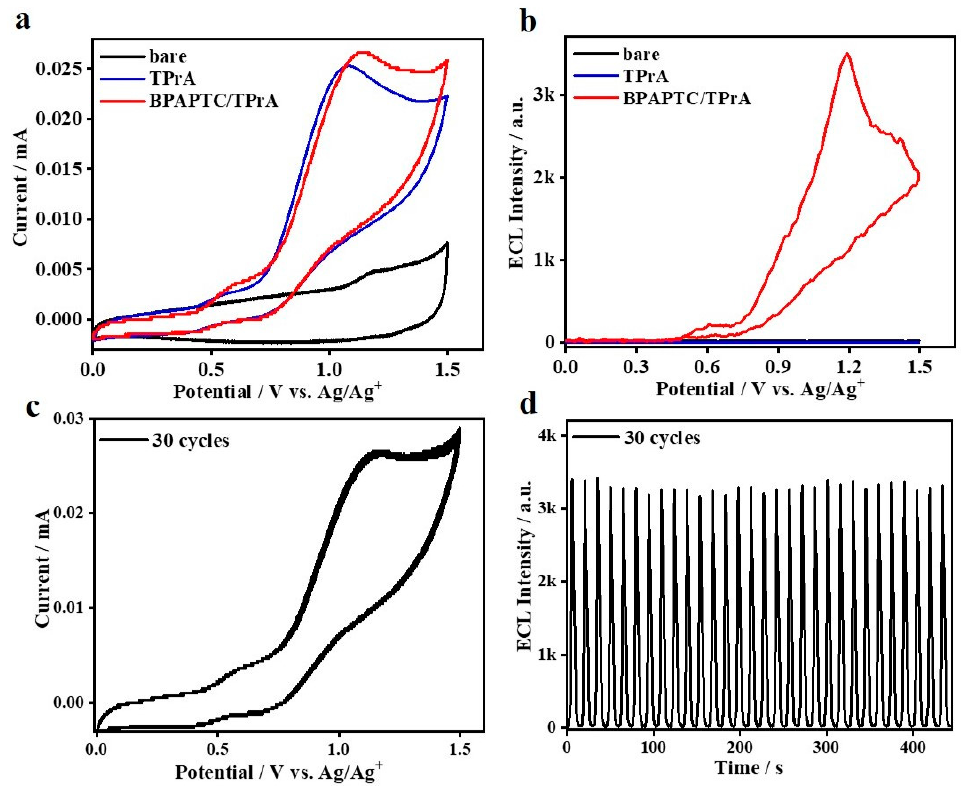
Figure 5. ( a ) CVs and ( b ) ECL curves of bare DCM, bare DCM containing 25 mM TPrA, 0.1 mM BPAPTC containing 25 mM TPrA. ( c ) Stability of CVs and ECLs ( d ) of the couple of 0.1 mM BPAPTC/25 mM TPrA.